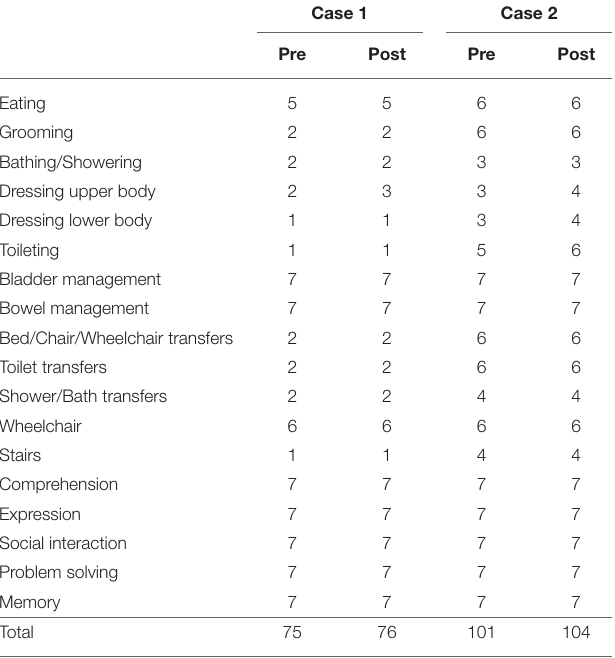
TABLE 3 | Change in FIM